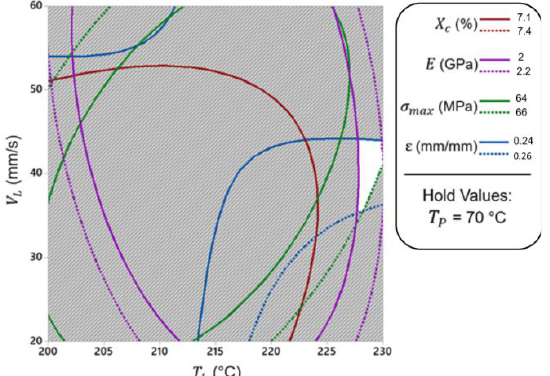
Figure 4. Multi-response optimization with reference to the liquefier temperature and print speed.